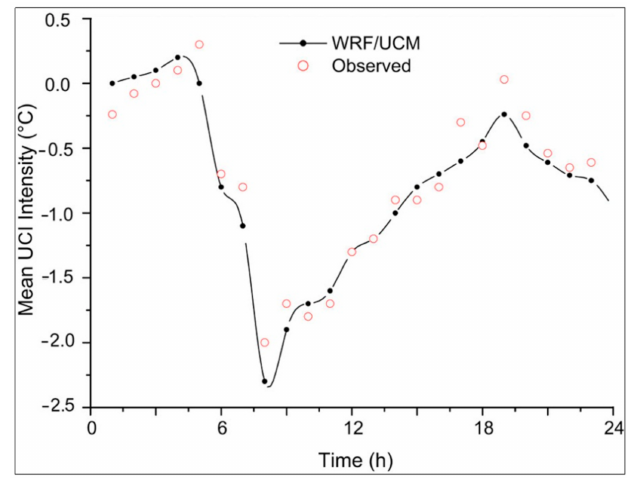
Figure 10. Daily variation of mean intensity of urban cooling